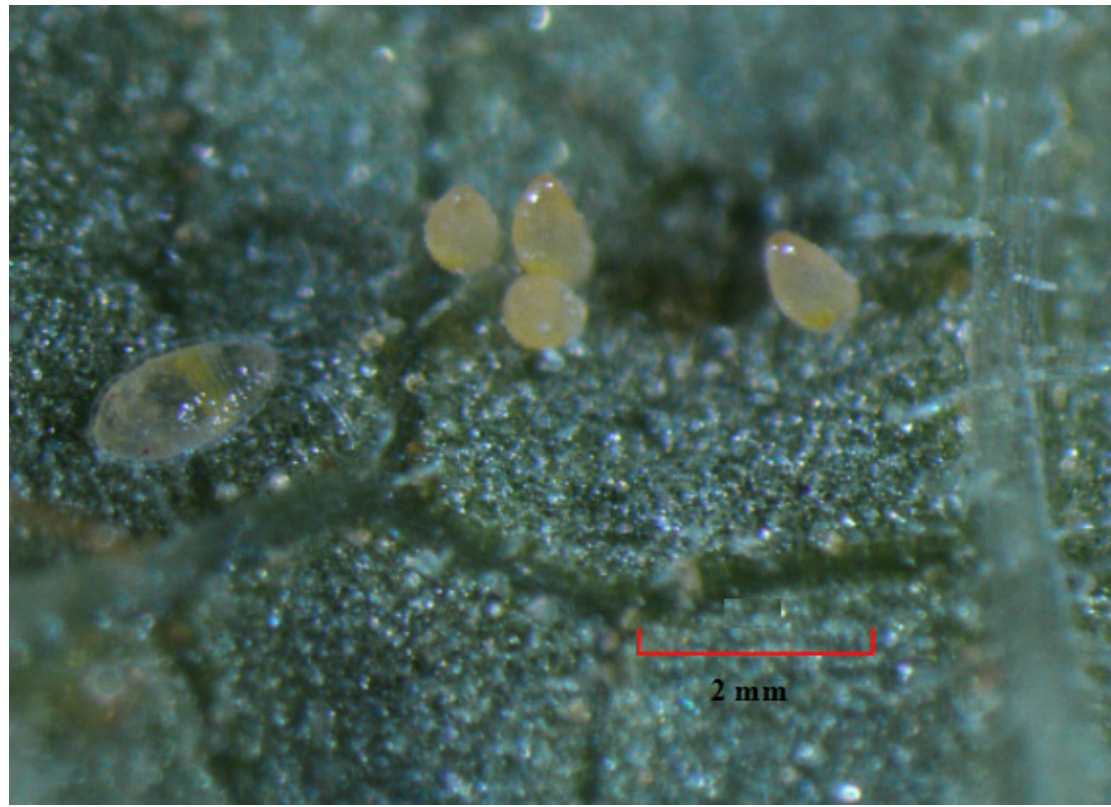
Figure 2. Bemisia tabaci eggs and first instar nymph on the underside of a snap bean leaf under microscope with 40× magnification (Li et al., unpublished).